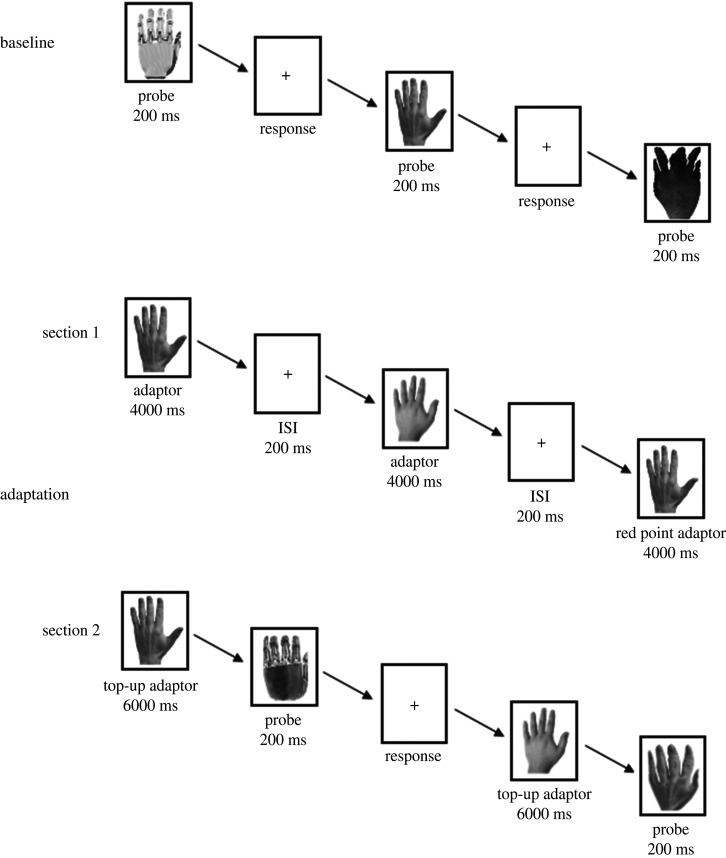
Trial format and experimental procedure. The trial format of baseline 1 was the same as that of baseline 2.